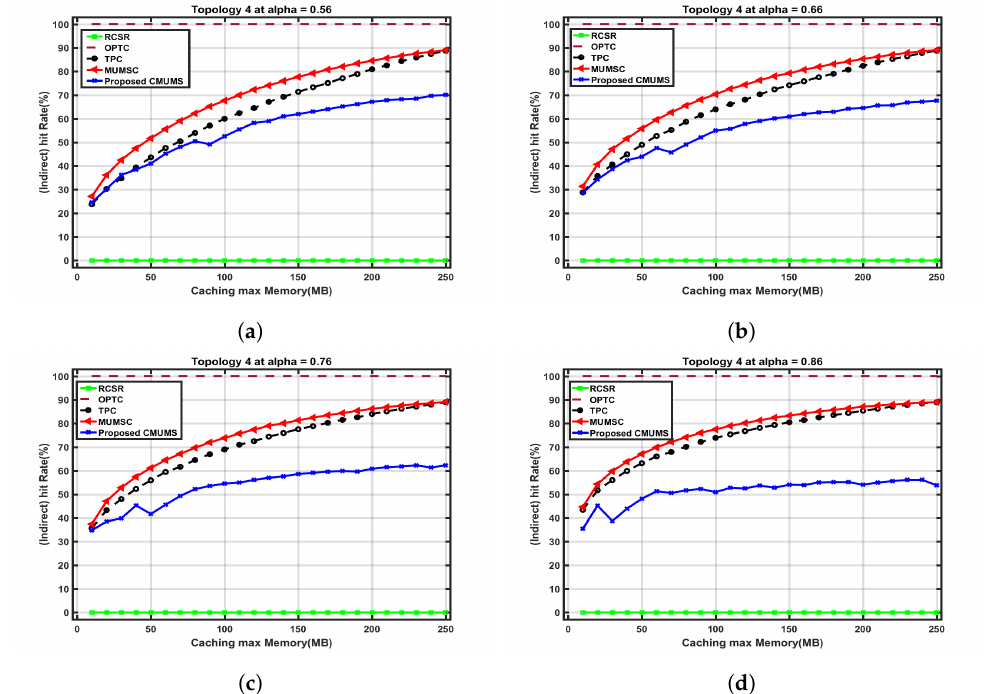
Figure 10. Indirect hit rate vs. caching max Memory (Q) up to 250 MB at different α . ( a ) Indirect hit rate vs. Q (at α = 0.56 as per [21]); ( b ) Indirect hit rate vs. Q at α = 0.66; ( c ) Indirect hit rate vs. Q at α = 0.76; ( d ) Indirect hit rate vs. Q at α = 0.86. Table 5. Indirect hit rate at different α for comparing the referenced algorithms in [21] with CMUMS at Q = 250